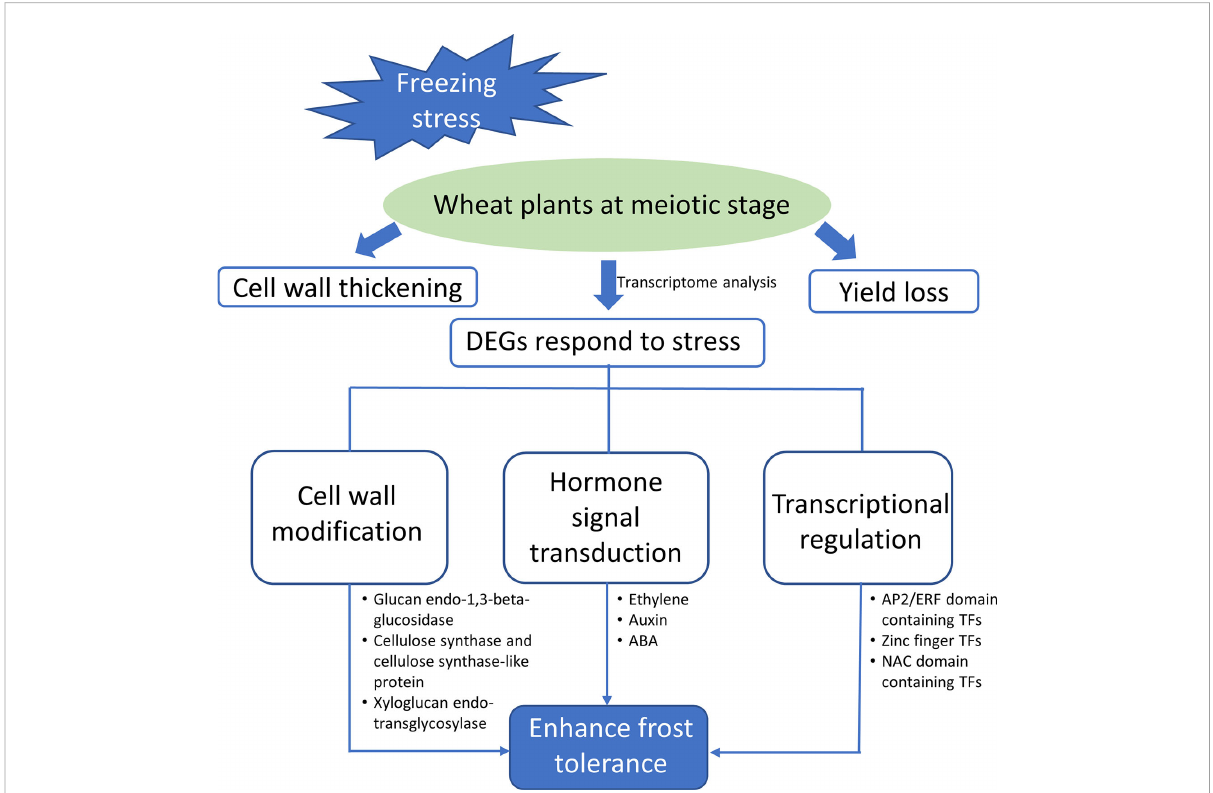
FIGURE 6 Schematic diagram showing the freezing induced changes of gene expression in wheat stems during meiosis. DEGs were mainly participated in pathways of cell wall modi fi cation, hormone signal transduction and transcriptional regulation to promote the freezing tolerance of